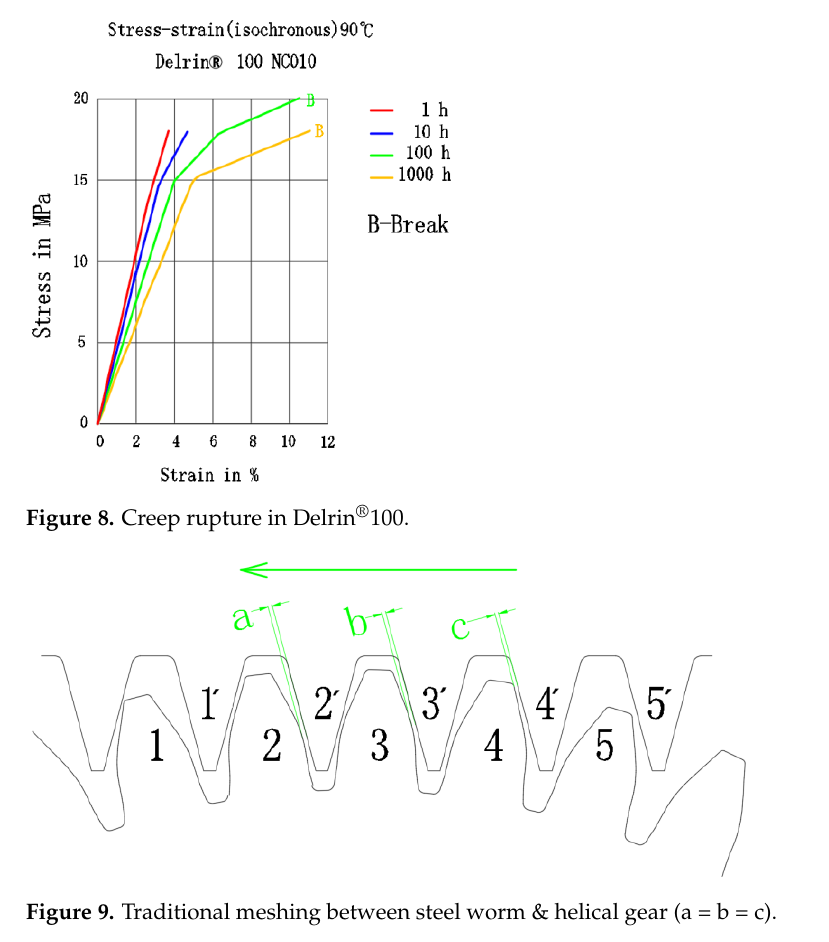
Figure 9. Traditional meshing between steel worm & helical gear (a = b = c).